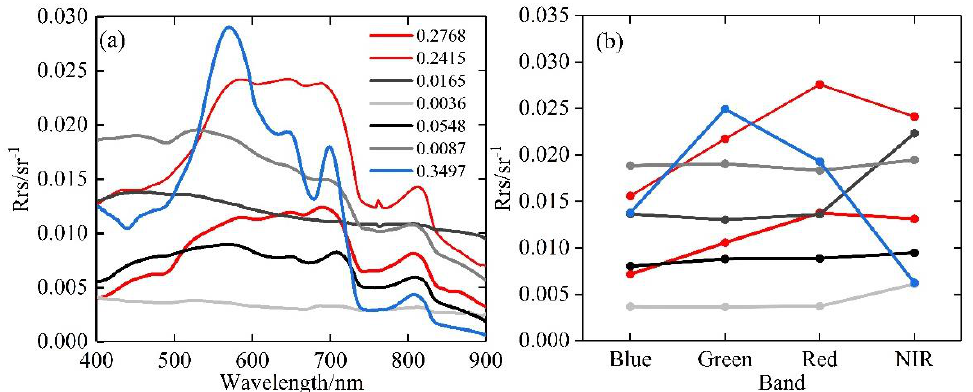
Figure 7. Spectral curve comparison. ( a ) The figures in the legend show the Pe determined according to the remote sensing reflectance. Two red curves show that the Pe of the water with SBOW was mistakenly recognized as a GW. The four black curves show that the Pe of the water with SBOW remained classified as SBOW after calculation, and the blue curve shows a GW. ( b ) The remote sensing reflectance after the equivalent band of the satellite sensor corresponding to ( a ).